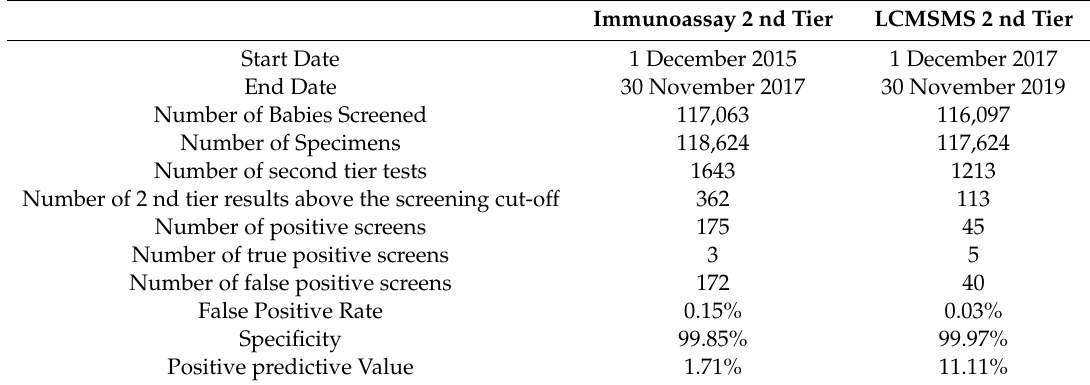
Table 3. Newborn Screening Metrics for CAH before and after LCMSMS